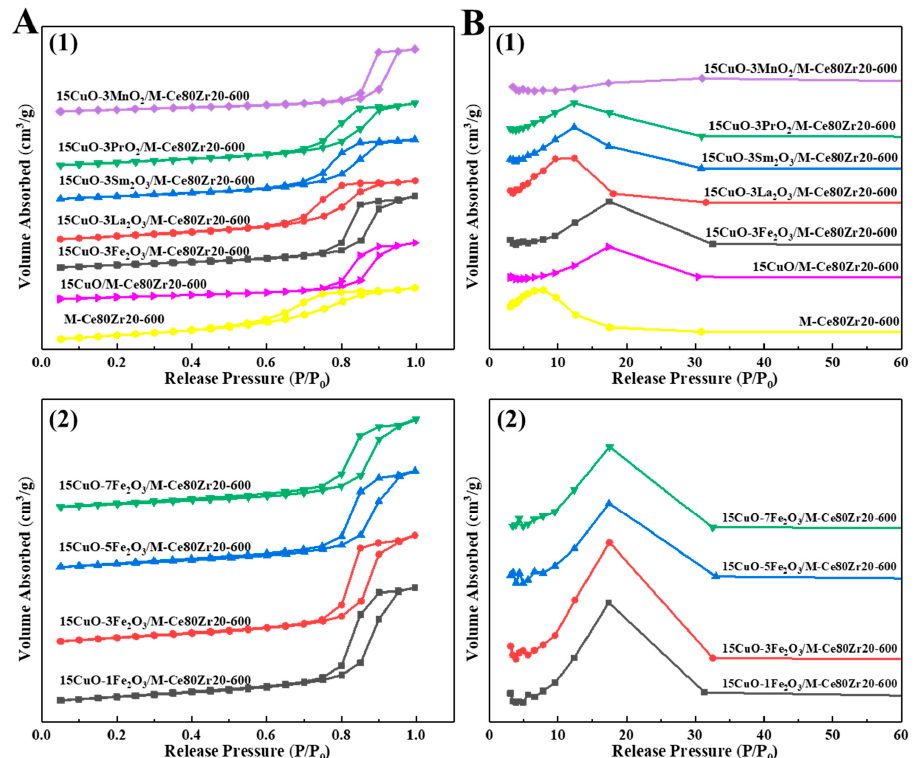
Figure 2. N 2 adsorption-desorption isotherms ( A ) and pore size distributions ( B ) of the catalytic support and the catalysts: ( 1 ) M-Ce80Zr20 and 15CuO-3MO x / M-Ce80Zr20 (MO x = La 2 O 3 , Fe 2 O 3 , PrO 2 , Sm 2 O 3 , MnO 2 ), ( 2 ) 15CuO- z Fe 2 O 3 /